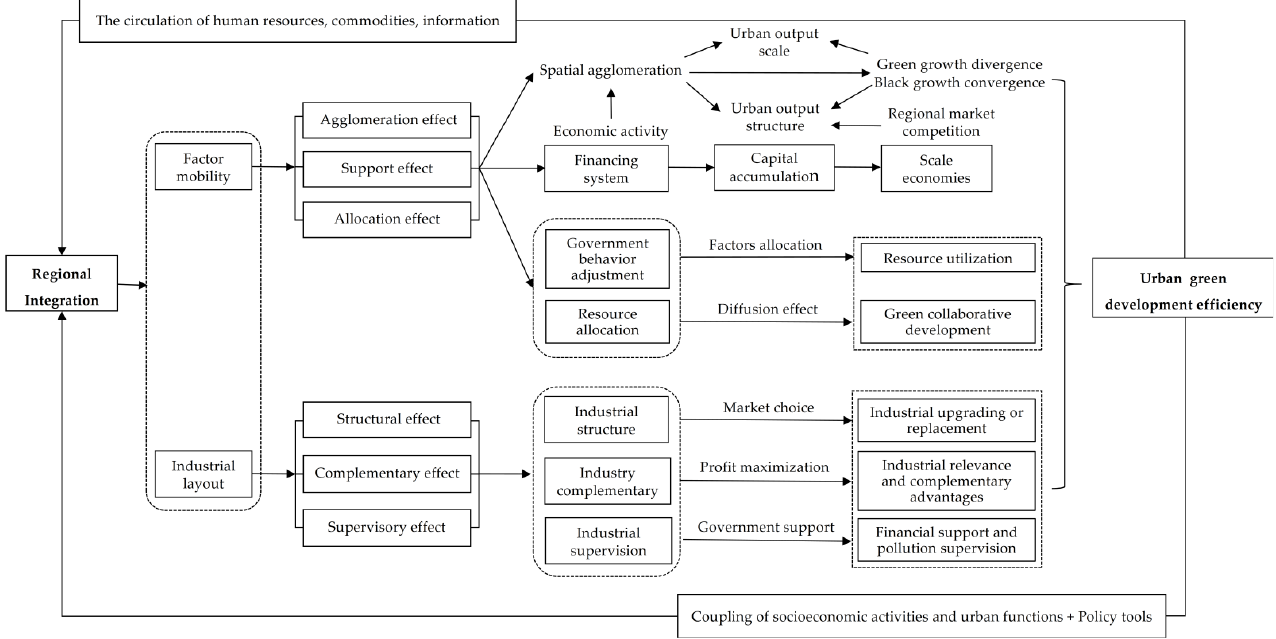
Figure 1. Interaction mechanism between regional integration and the